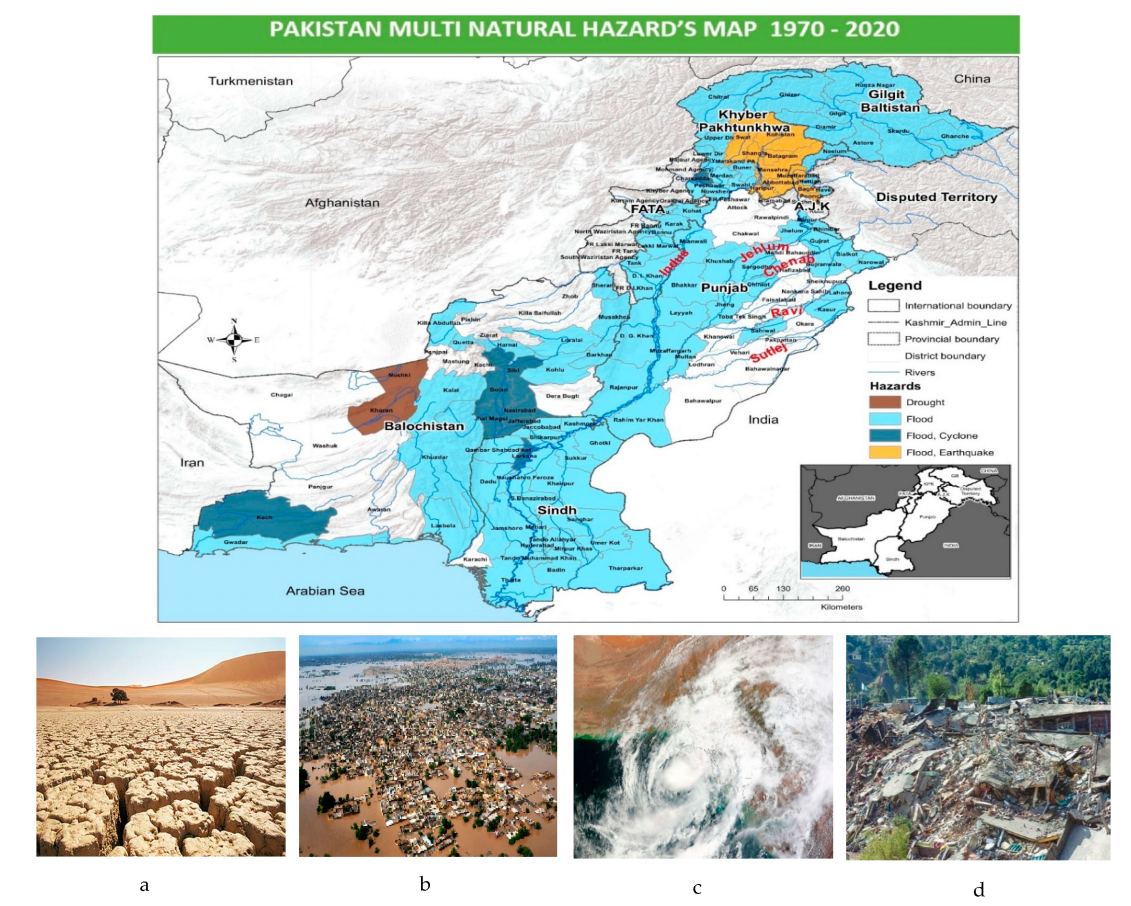
Figure 16. The pattern of total Risk from Multi Natural Hazards in Pakistan at the district level and images of natural hazards and extreme events in the study area: ( a ) drought of 1998–2002, considered the worst in 50 years in Baluchistan, Pakistan; ( b ) damages of 2010 flooding in Pakistan; ( c ) 2010 cyclone in Pakistan; and ( d ) damages of the 8 October 2005 earthquake, AJK, Pakistan.